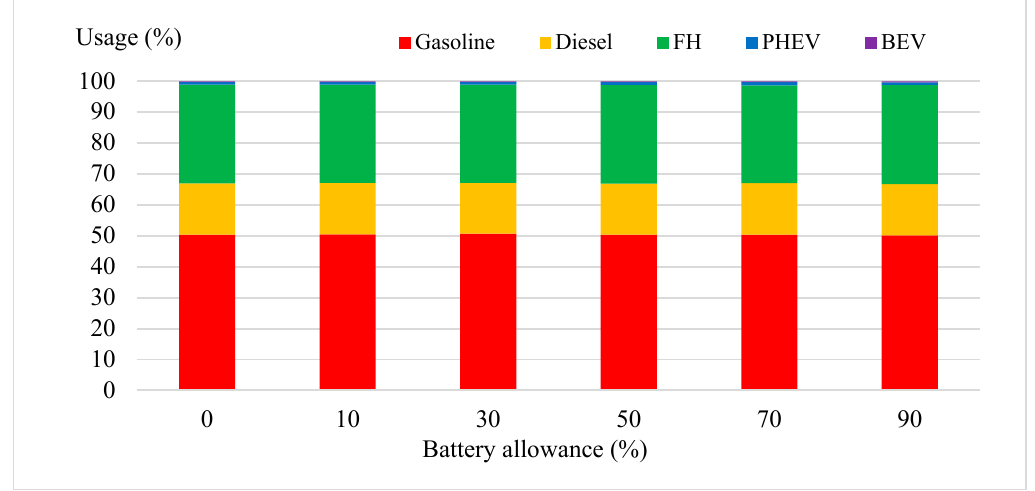
Figure A2. Market simulation results (Scenario A-1: Korean energy mix in 2030).